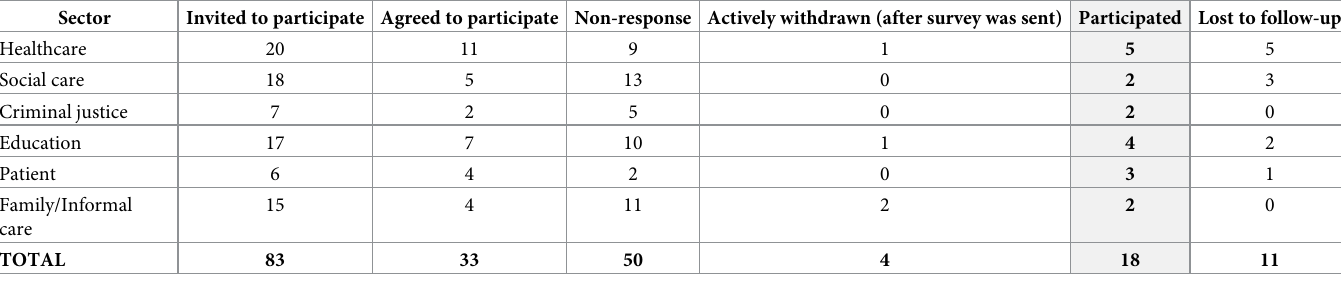
Table 1. Survey participants for